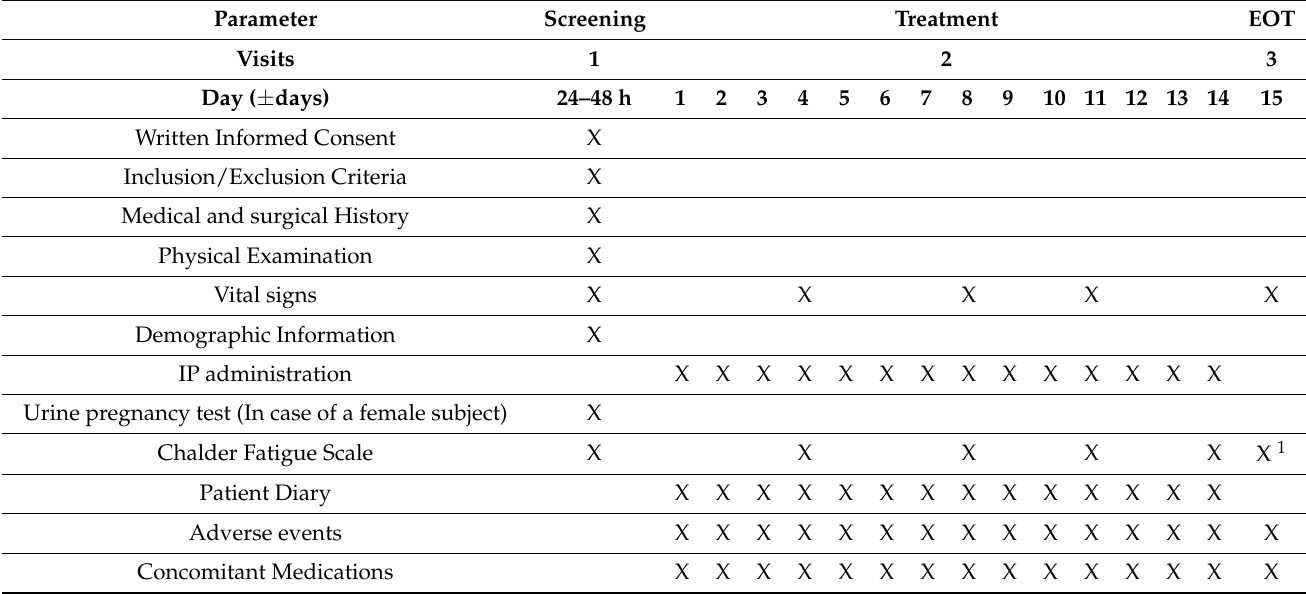
Table 1. Schedule of assessments.